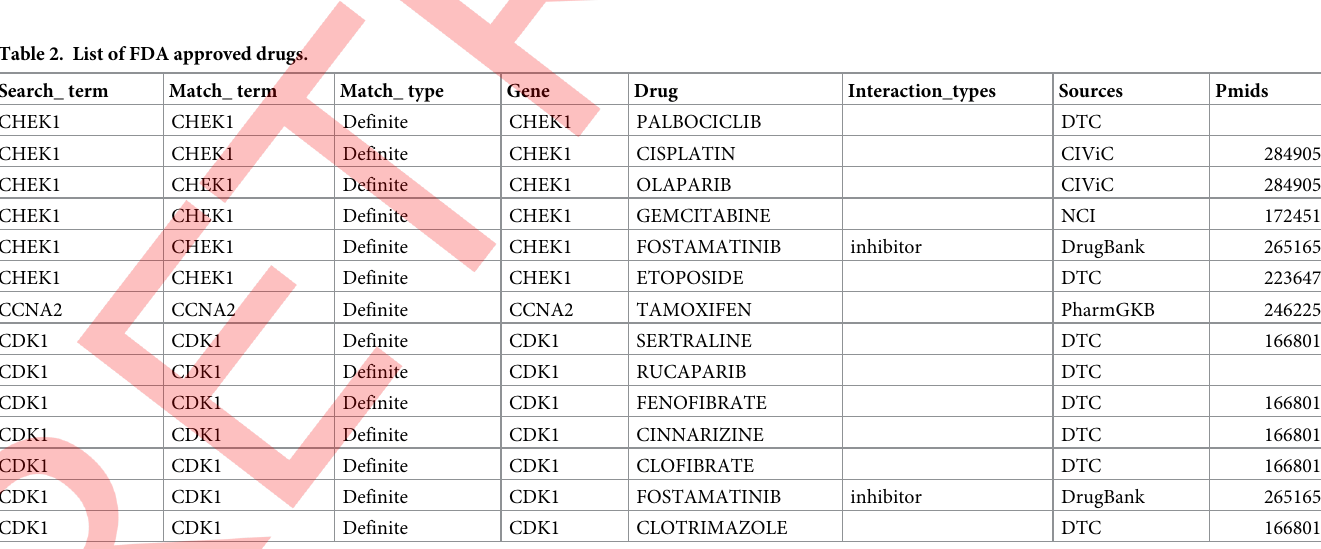
Table 2. List of FDA approved